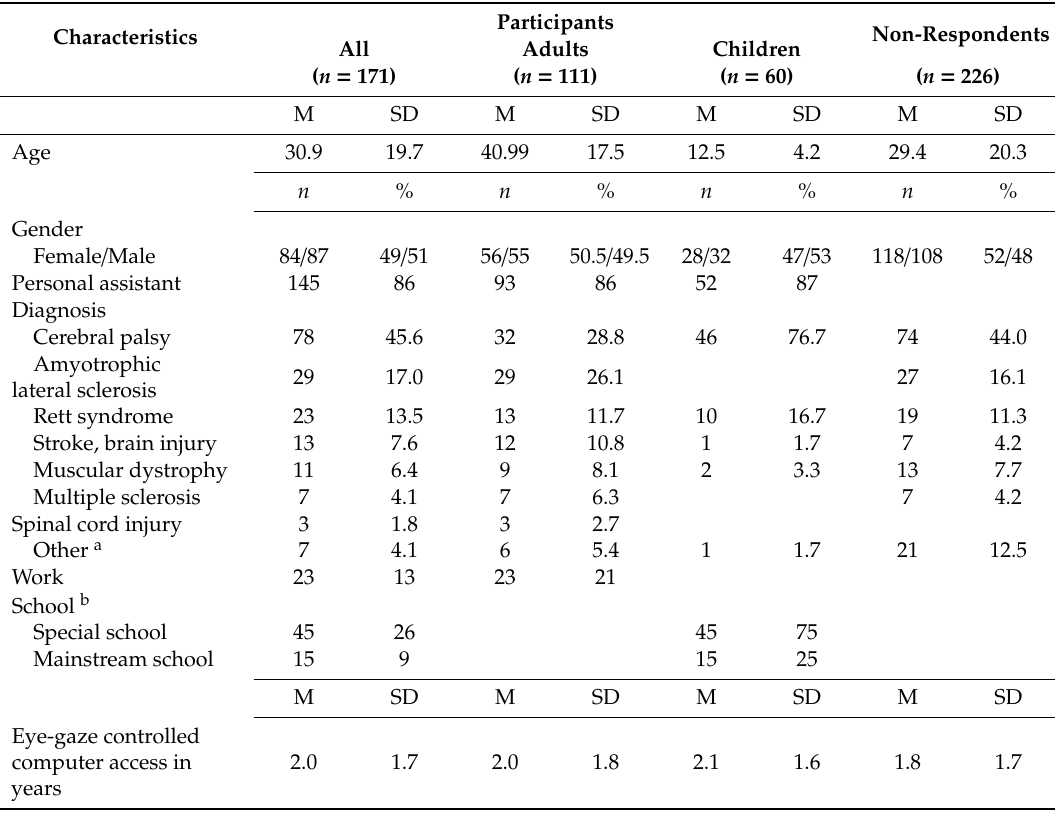
Table 1. Participants’ and non-respondents’